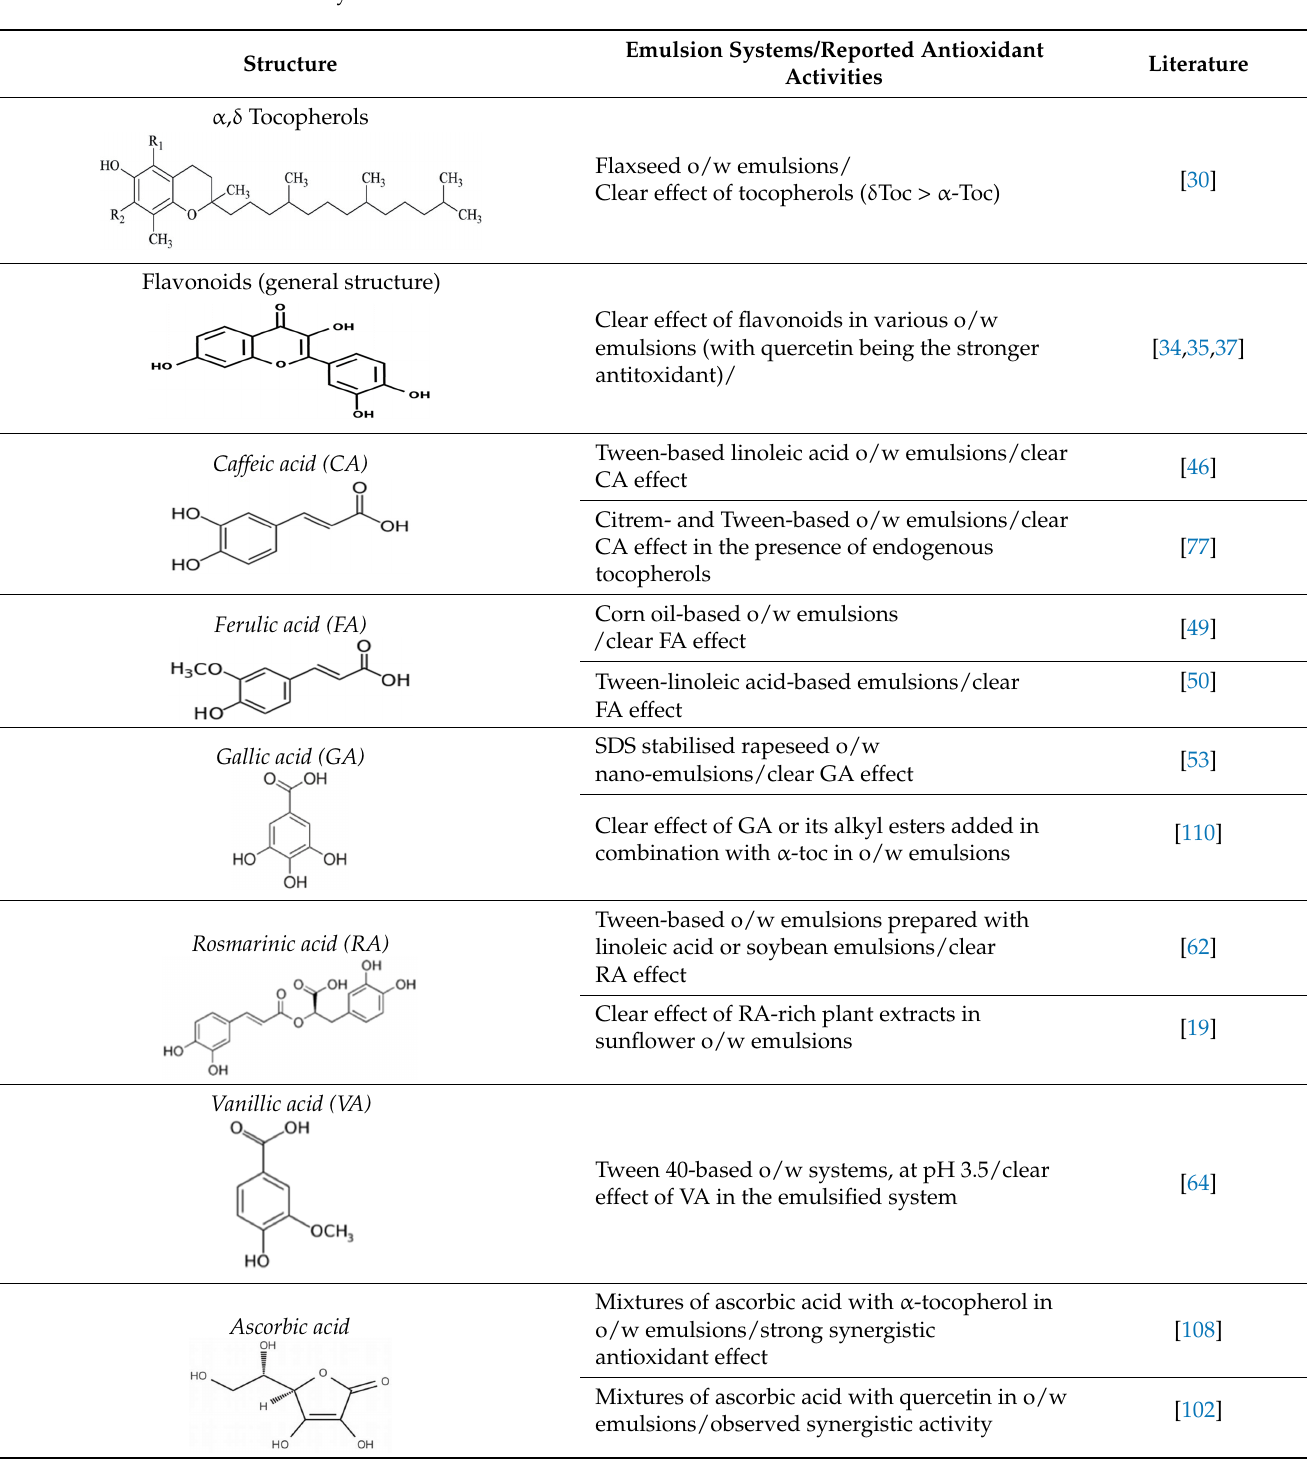
Table 1. Overview of literature reporting a clear antioxidant activity of certain phenolic compounds (alone or in combinations) against oxidative deterioration of various model oil-in-water emulsion systems.